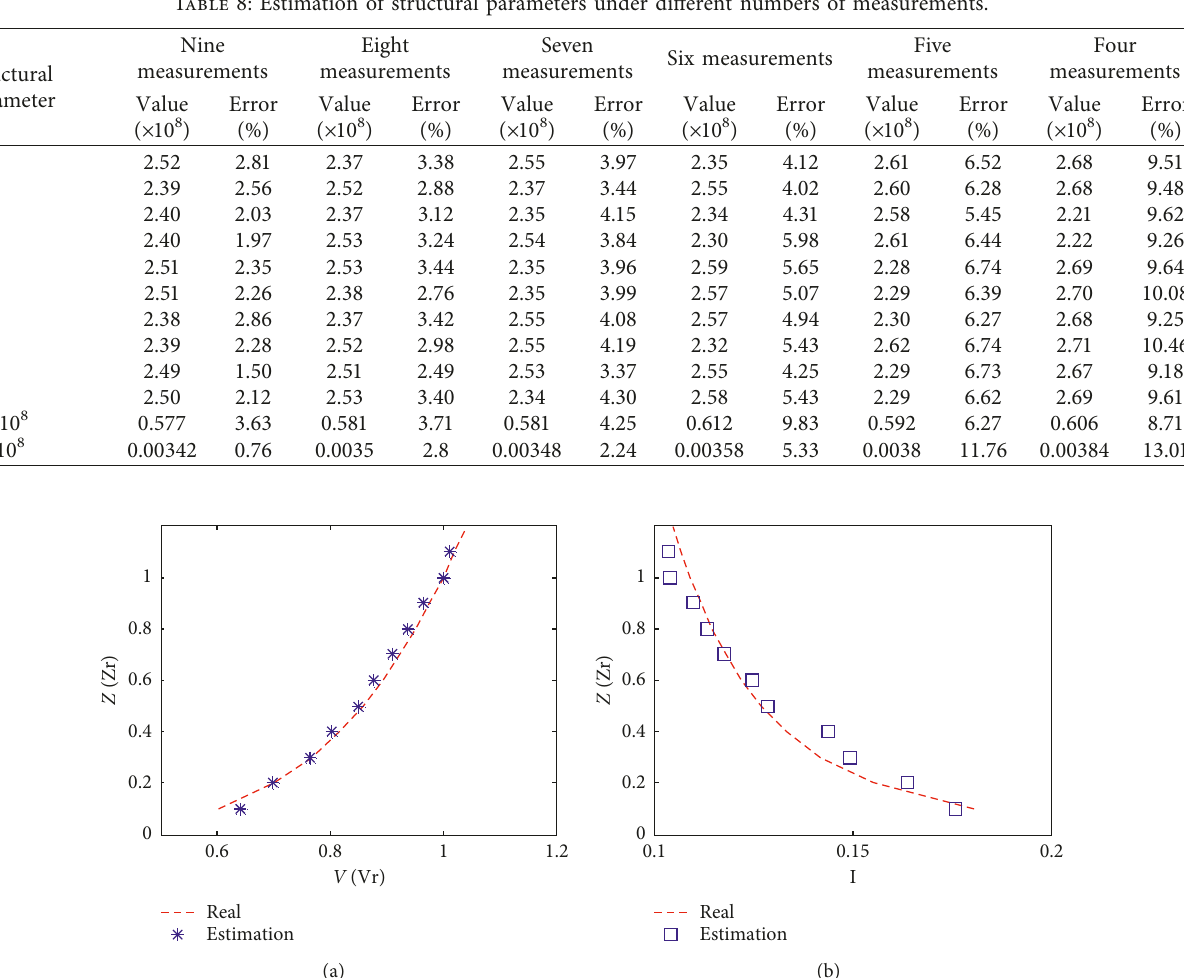
Figure 11: Mean wind speed and turbulence intensity profiles: (a) mean wind speed; (b) turbulence